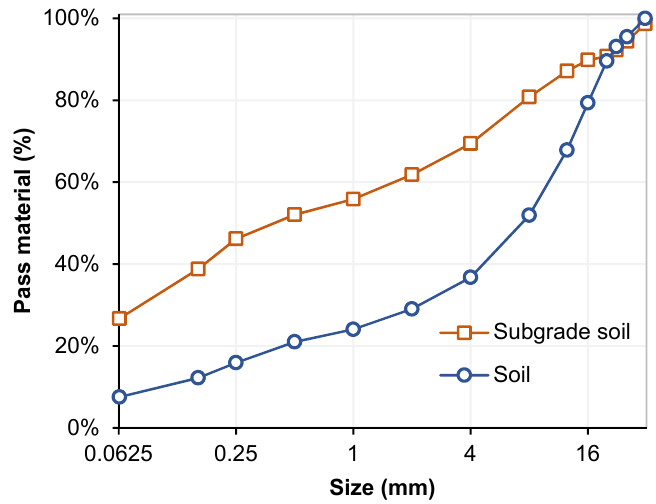
Figure 2. Particle size distribution of soils. Table 1. Properties of the tested